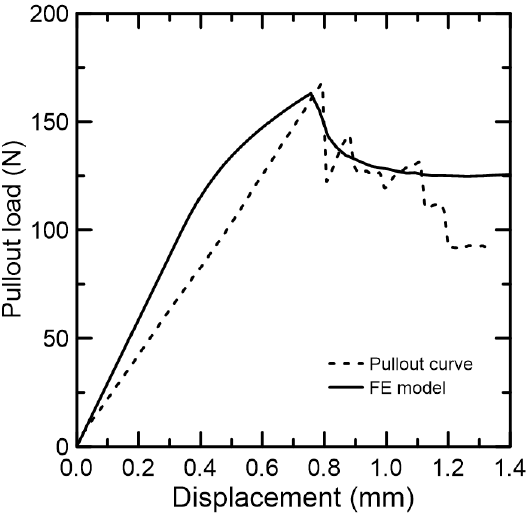
Figure 16. Simulated and experimental pull-out